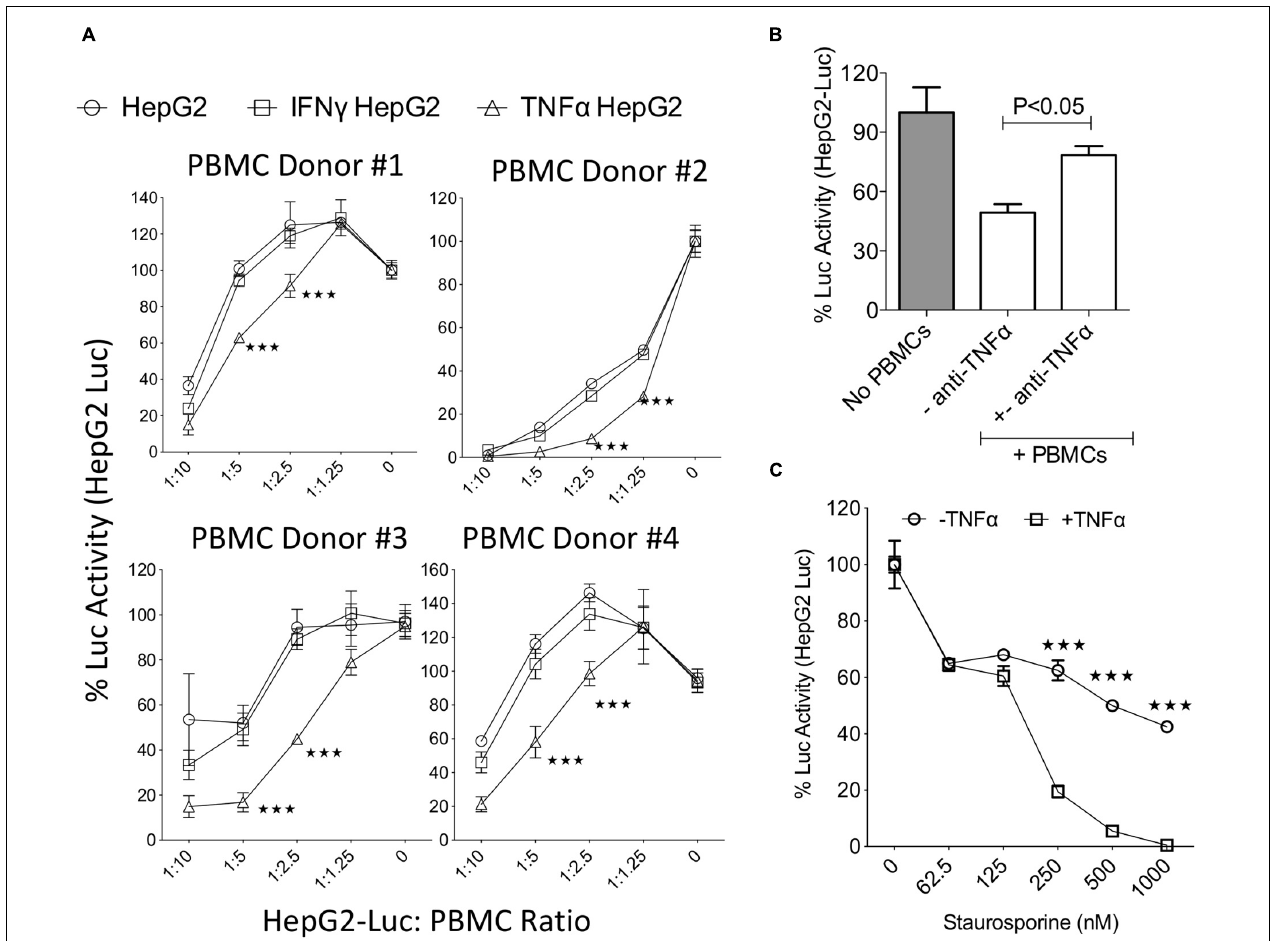
FIGURE 2 | TNF α increases the susceptibility of HepG2 cells to lysis. Luciferase expressing HepG2 cells were treated with IFN γ and TNF α before co-culture with SEB activated PBMCs. Three days post co-culture luciferase activity was measured in a luminometer. (A) Dose dependent effect of SEB activated PBMCs from independent PBMC donors on the relative luciferase activity of IFN γ and TNF α treated HepG2-Luc cells were shown. Percentage luciferase activity was calculated based on the readouts of HepG2-Luc cells without PBMCs. Appropriate HepG2-Luc: PBMC ratio is shown in X axis and 0 indicates only HepG2-Luc without PBMCs. Two-way analysis of variance (ANOVA) multiple-comparison test was performed between the independent conditions. *** P ≤ 0.001. Mean and standard deviation are shown from technical replicates. (A) Represents cumulative data obtained from four independent PBMC donors. (B) Monoclonal blocking antibody to TNF α (50 µ g/ml) was added in HepG2-Luc cultures with SEB activated PBMCs. Two days post culture, luciferase activity was measured. (C) ± TNF α activated HepG2-Luc cells were treated with the indicated concentrations of Staurosporine. Two days post culture, luciferase activity was measured. Two-way analysis of variance (ANOVA) multiple-comparison test was performed between the independent conditions. *** P ≤ 0.001. Mean and standard deviation are shown from technical replicates. Representative results were shown from two independent